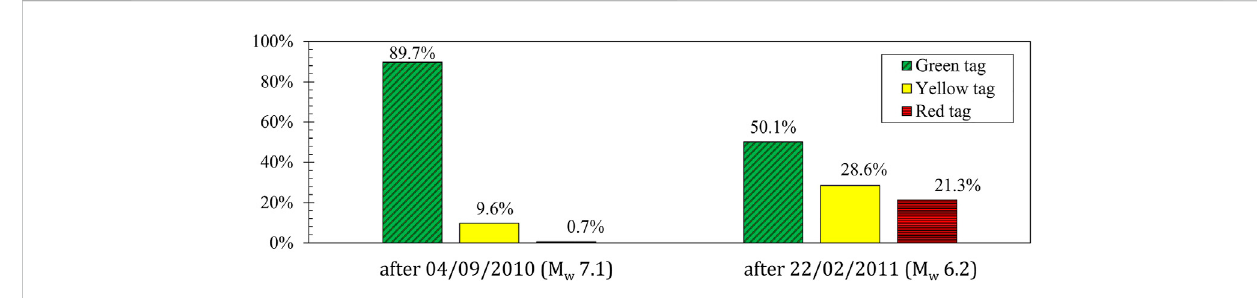
FIGURE 1 Building Safety Evaluation tagging in the Christchurch Central Business District after the 4/9/2010 Dar fi eld (Canterbury) earthquake and the 22/2/2011 Christchurch (Lyttelton) earthquake (data from Kam et al., 2010; Kam et al., 2011). M w is the moment magnitude of those